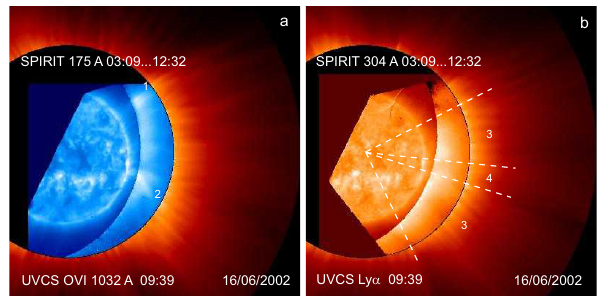
Fig. 6. Composite SPIRIT (at R =1...1.6) and the UVCS images (at R =1.6...3.5): (a) SPIRIT 175 ˚A and UVCS OVI 1032 ˚A. 1 and 2 – the rays in the SPIRIT having the counterparts in the UVCS image; (b) SPIRIT 304 ˚A and UVCS Ly α . In both images the brightness in sector 3 is relatively higher than in sector